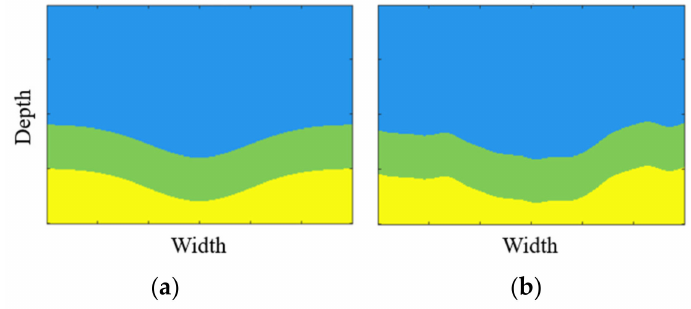
Figure A6. Fold model ( a ) without and ( b ) with random fluctuations.